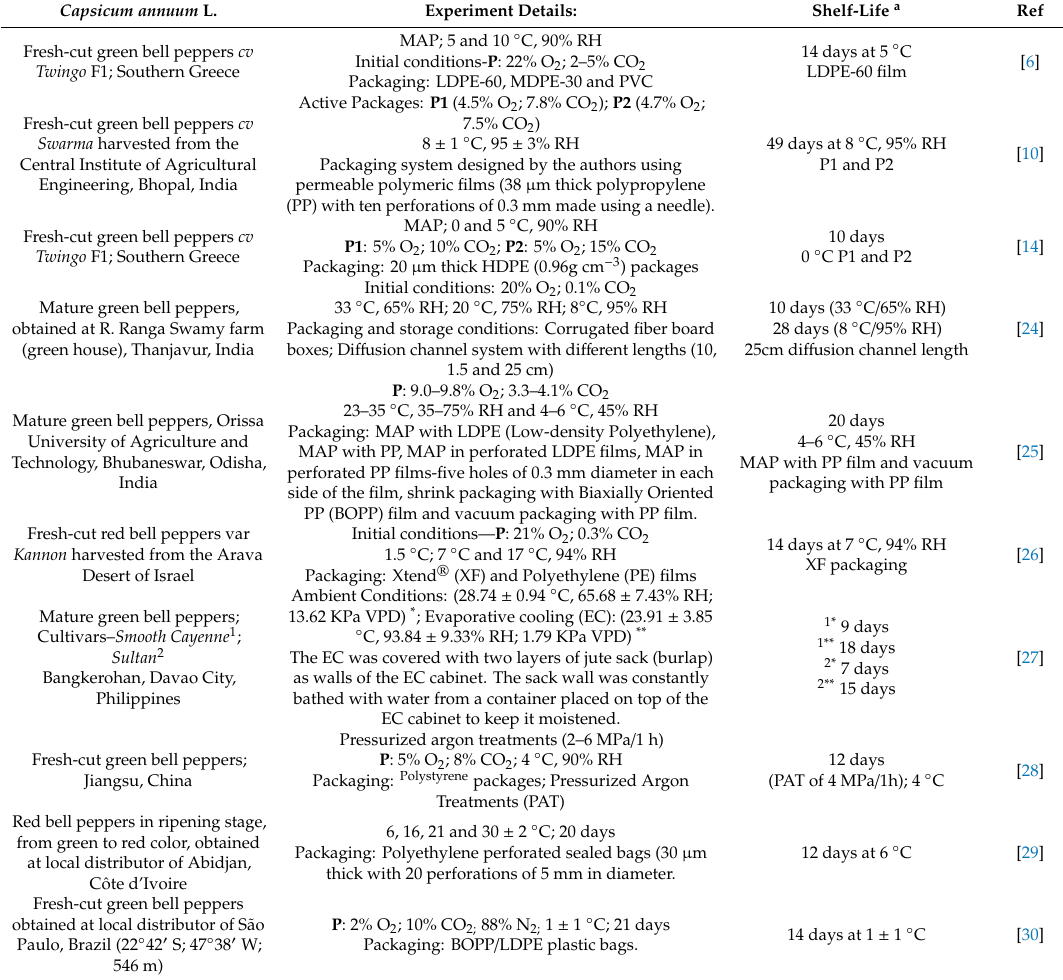
Table 2. Shelf life of fresh bell peppers ( Capsicum annuum L.) stored at di ff erent packaging conditions. Capsicum annuum